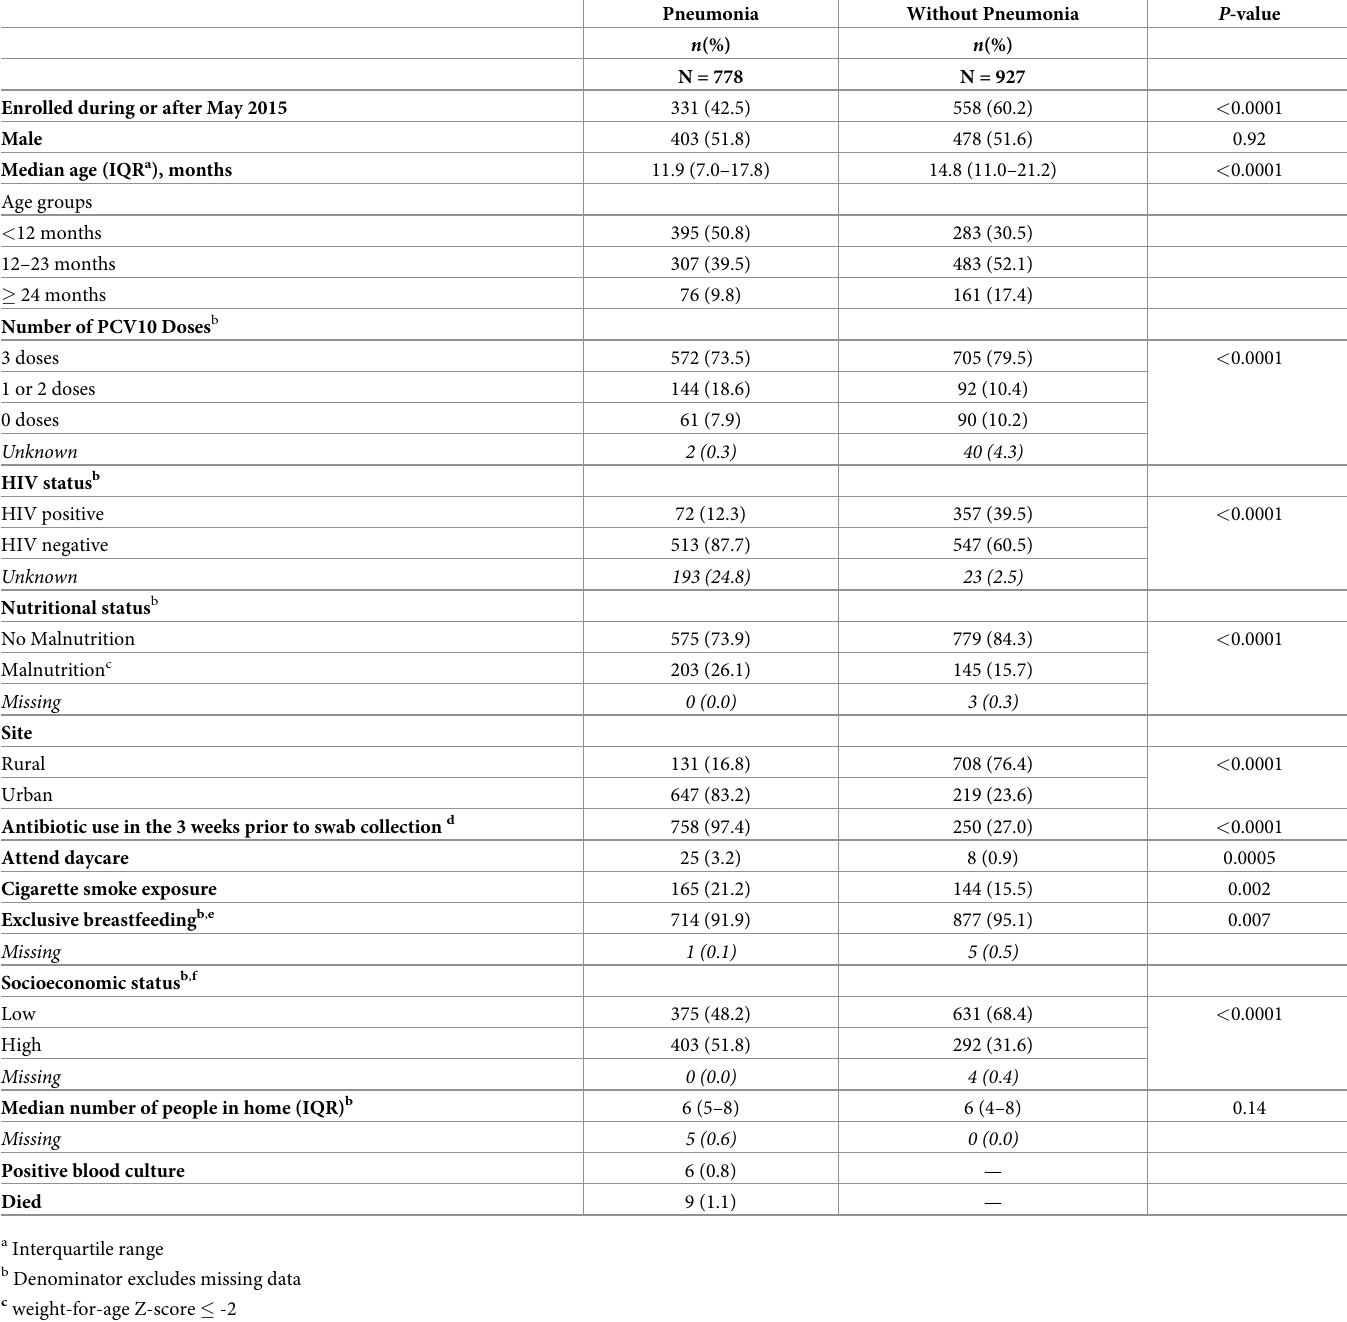
Table 1. Characteristics of children aged < 5 years with and without pneumonia in Manhic¸a and Maputo, Mozambique, 2014–2016.